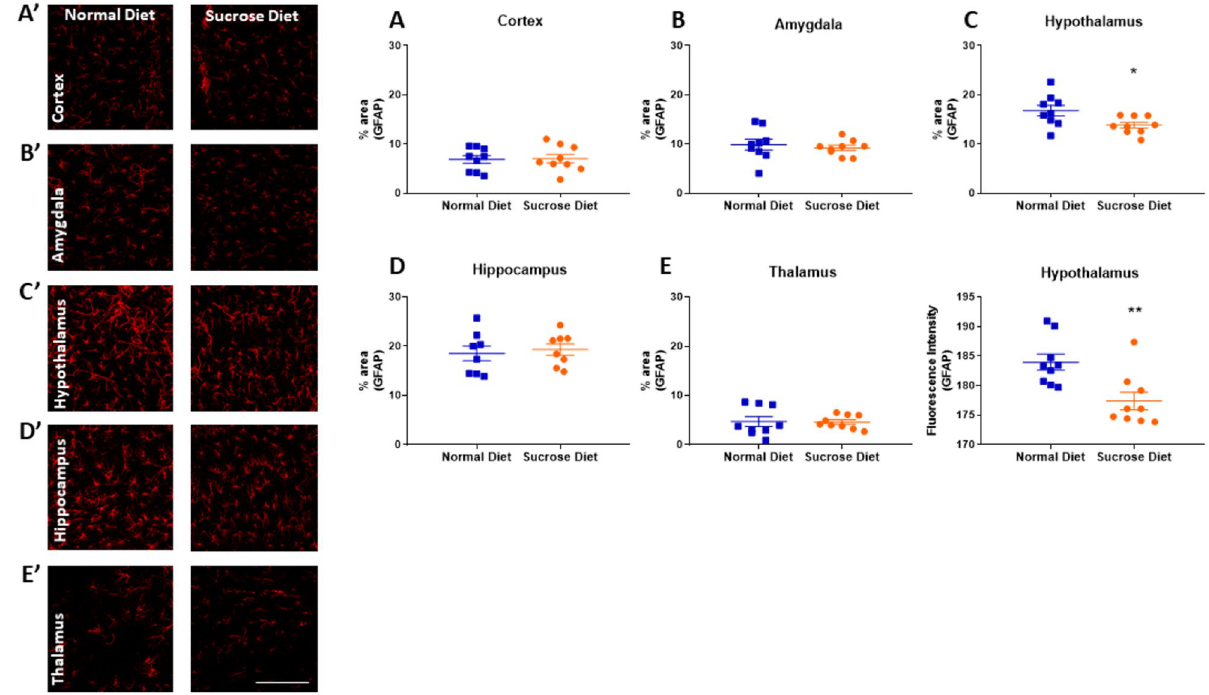
Figure 6. Effect of 12-week binge sucrose intake on astroglial cells in rats. Immunohistological analysis revealed no effect of sucrose diet on the astrocyte coverage in the ( A ) motor cortex, ( B ) amygdala, ( D ) hippocampus and ( E ) thalamus as stained with GFAP (red). ( A’ – B’ and D’ – E’ ) shows representative staining in each of these regions in the normal diet (left panel) and sucrose diet (right panel) groups, scale bar = 100 µm. ( C ) The area covered and ( F ) fluorescence intensity of astrocytes staining was reduced in the hypothalamus of the sucrose diet rats. ( C’ ) Representative staining of the astroglial marker GFAP in the hypothalamus in the normal diet (left panel) and sucrose diet (right panel) groups, scale bar = 100 µm. All values are presented as mean area covered with GFAP positive staining ± SEM or mean GFAP fluorescence intensity ± SEM in the brain region imaged analysed with Student’s two-tailed t-test. *p < 0.05, **p < 0.01 compared to controls. All values presented are from n = 9 per